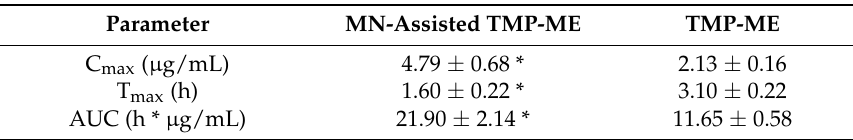
Table 2. TMP pharmacokinetic parameters for TMP-ME and MN-assisted TMP-ME in the skin microdialysis study.